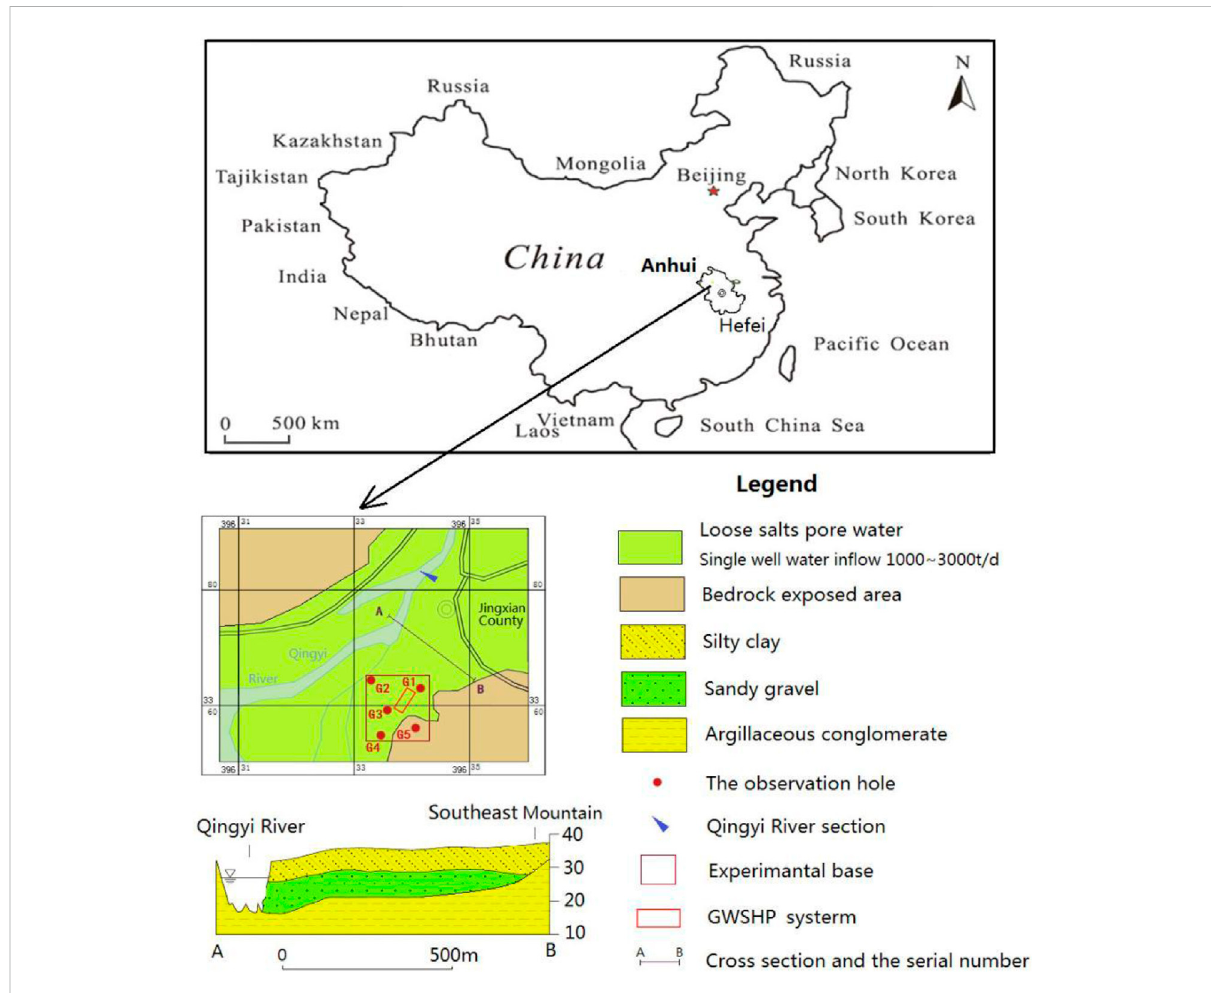
FIGURE 1 Regional hydrogeology map of the study